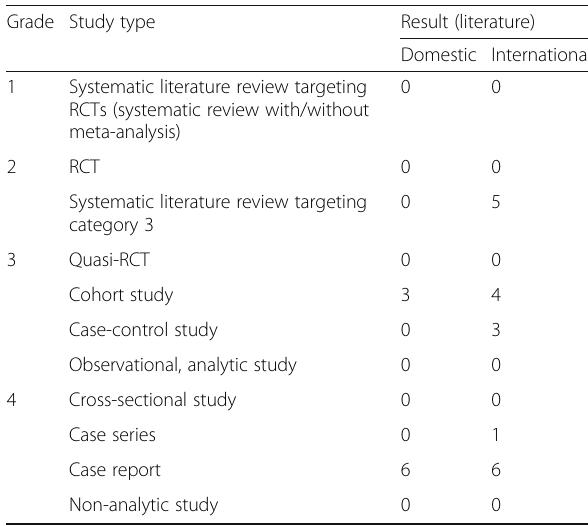
Table 2 Status of the evidence levels of domestic